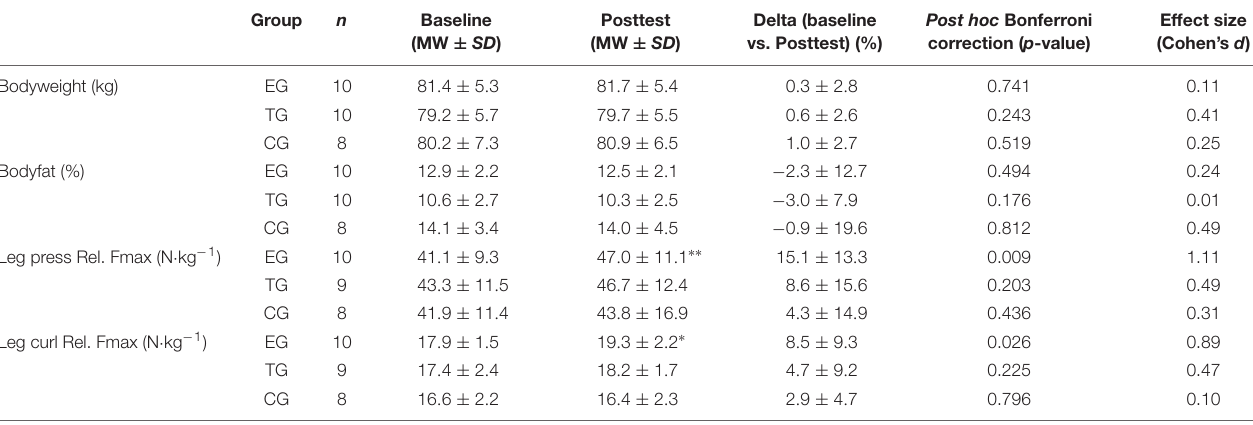
TABLE 2 | Results for anthropometric data and relative maximal strength (Frel) at leg press and leg curl for EMS-Group (EG), Training-Group (TG), and Control-Group (CG) 1 week before (Baseline) and 1 week after intervention period (Posttest). Group